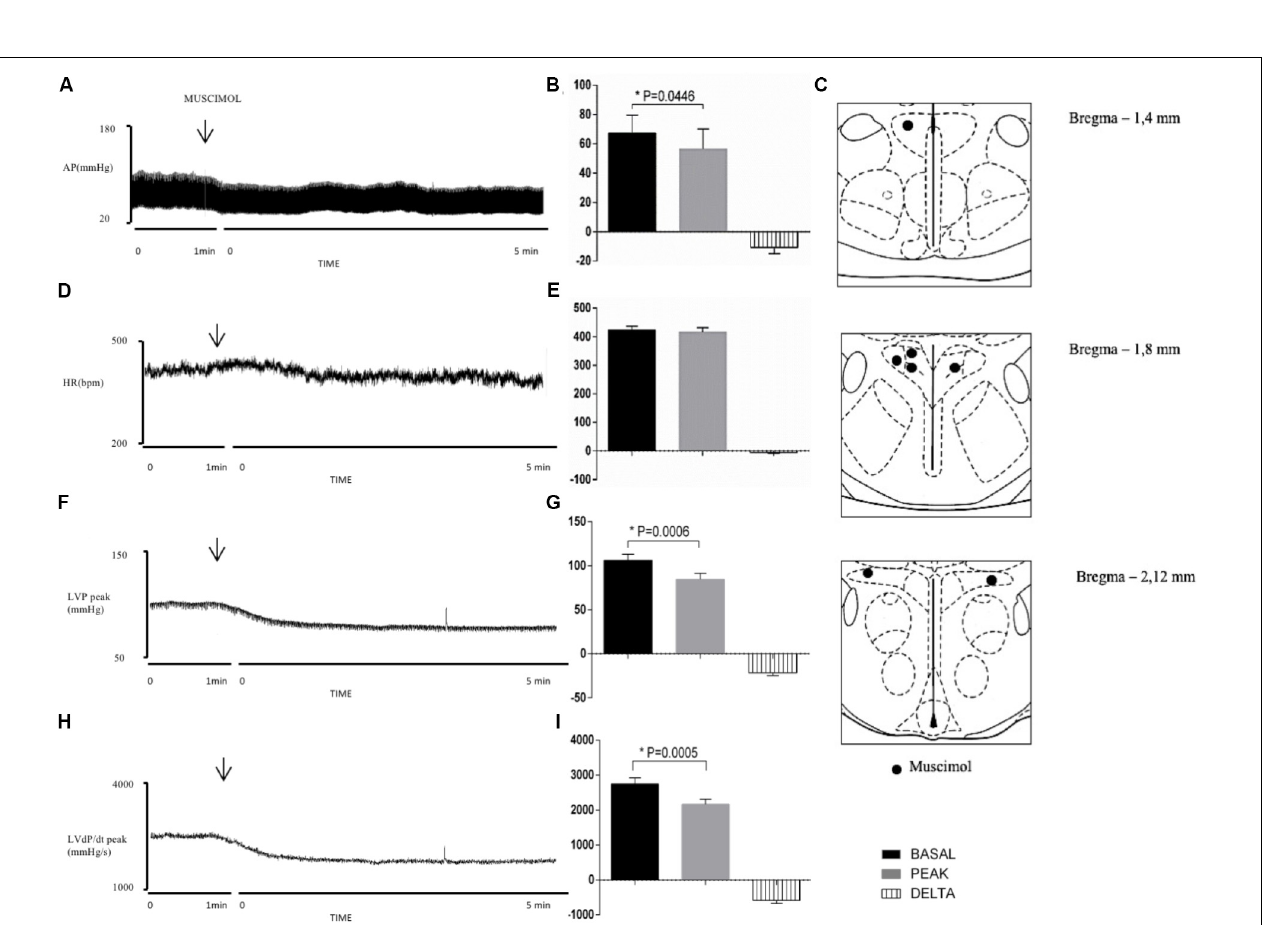
FIGURE 2 | Left column – Chart records illustrating the responses of MAP (A) , HR (D) , LVP peak (F) , and LVdP/dt peak (H) produced by the unilateral microinjection of muscimol in the PVN (arrows indicate the moment of injection). Middle column – Mean maximal changes in MAP (B) , HR (E) , LVP peak (G) , and LVdP/dt peak (I) in response to unilateral microinjections of muscimol (100 nl). Values refer to the means collected in the basal period (2 min before the central injection), and at the maximum point of response to microinjection of muscimol and its variation. ∗ P < 0.05. MAP, mean arterial pressure; HR, heart rate; LVP peak, maximum pressure in the left ventricle; LVdP/dt peak, first derivative of cardiac left ventricle pressure. Right column – Schematic representation of the injection sites stained by Evans blue dye from group injected with muscimol (100 nl) into PVN (C) . n = 7.